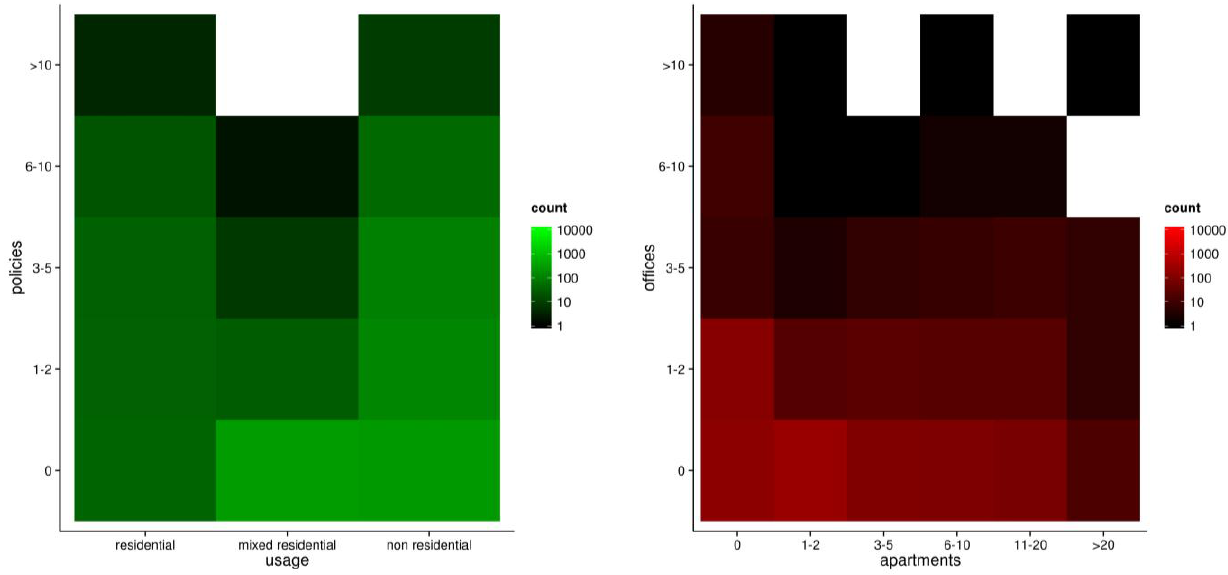
Figure 5. Composition of the training dataset of 1000 buildings randomly selected among the 19,158 buildings of the original dataset (“ count ” refers to the number of TCIP policies in the